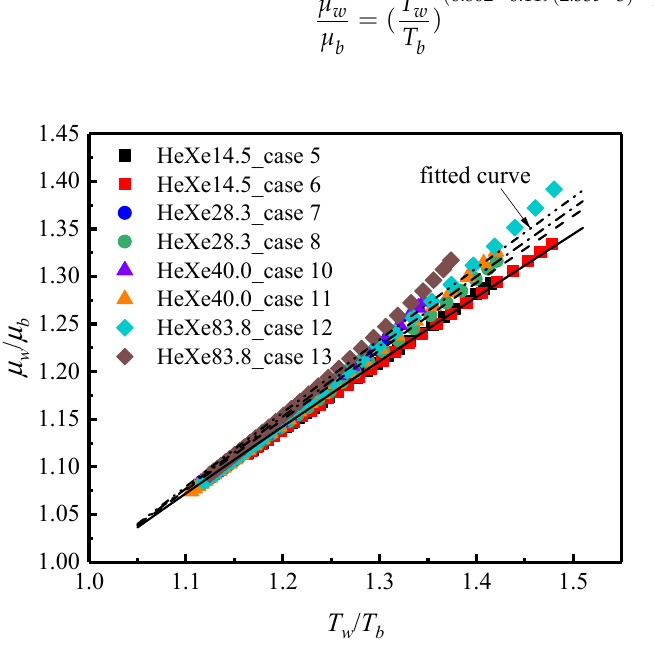
Figure 12. Variation of μ w / μ b with T w / T b for He–Xe. Combining Equations (3)–(5), the modified f correlation with temperature ratio for property-variable He–Xe laminar flow is obtained: